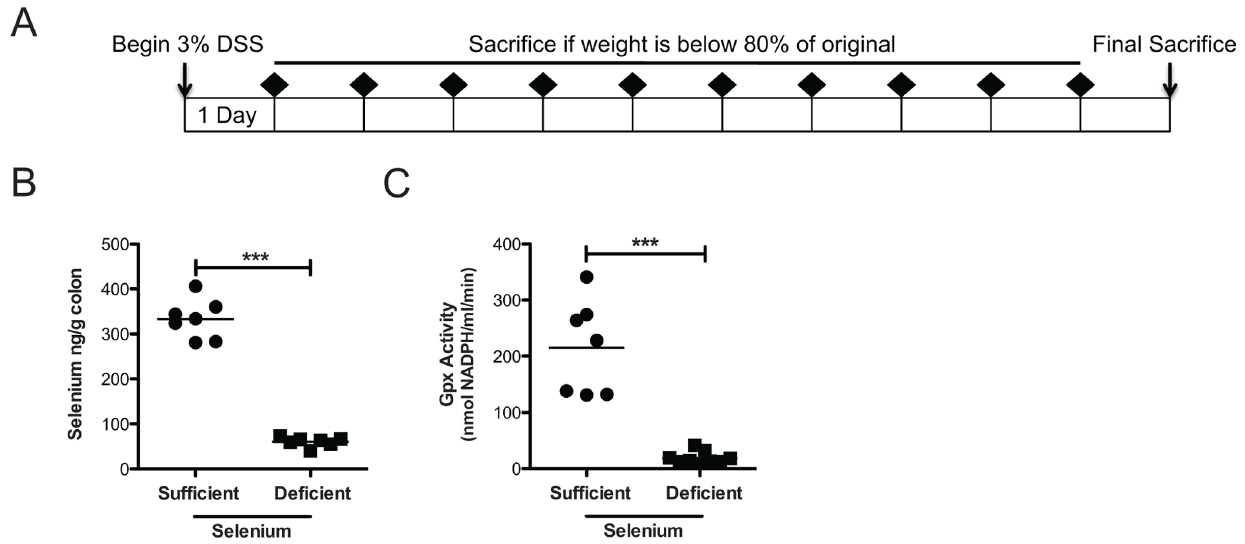
Figure 1. Dietary selenium depletion reduces colon selenium levels and plasma glutathione peroxidase activity. A. Schematic for the DSS morbidity protocol. At day 0, mice were weighed and then given a 3% DSS solution in lieu of drinking water. Each day, mice were weighed and stools were obtained for analysis of blood and stool consistency (weight and stool analyses times indicated by black diamonds). Individual mice were sacrificed if their weights fell below 80% of their original weights. B. Selenium sufficient (n=7) and deficient (n=7) colons were analyzed for selenium